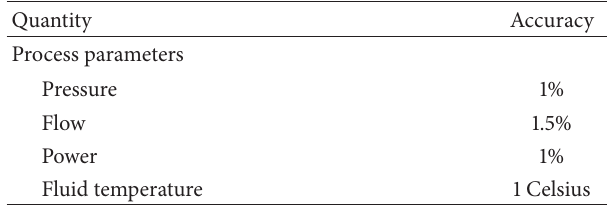
Table 11: Number of gamma-ray beams.